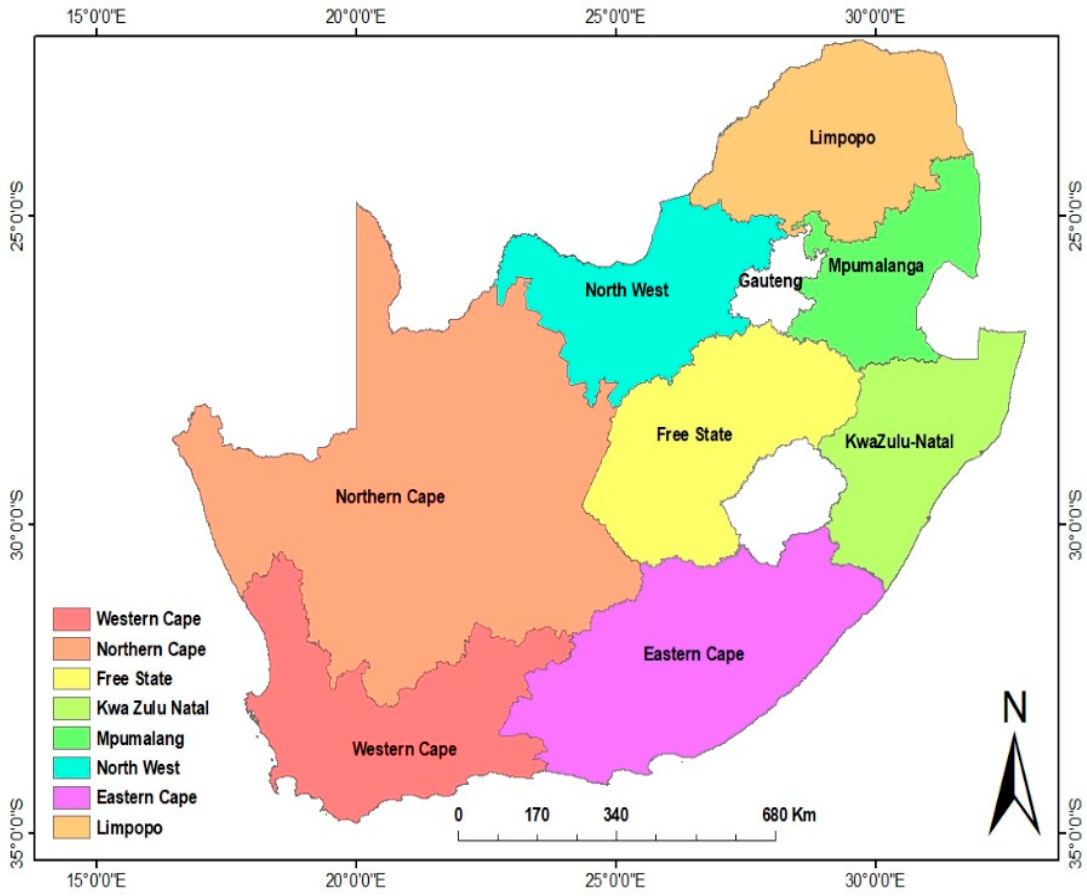
ff erent provinces of the